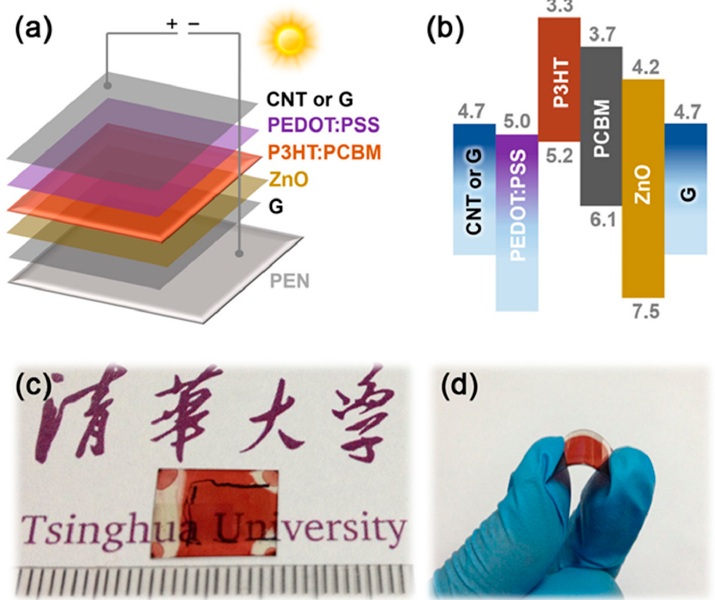
Figure 1. ( a ) Schematic illustration and ( b ) energy level diagram of the solar cells fabricated